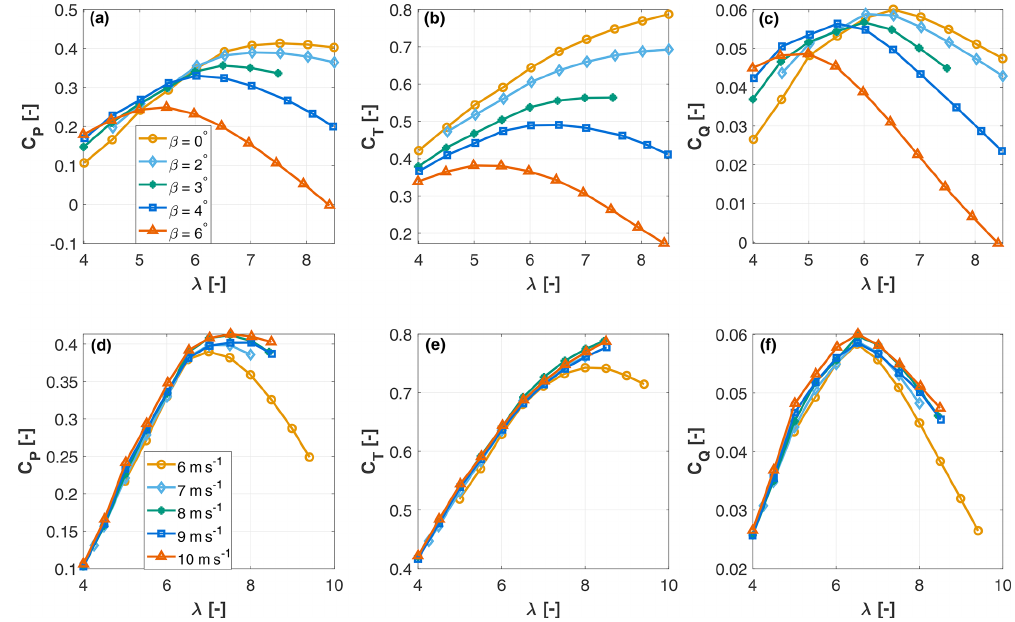
Figure 8. Power C P (a, d) , thrust C T (b, e) and torque C Q (c, f) coefficients as functions of TSR λ for different pitch angles β at 10ms − 1 (a– c) and for different wind speeds at the optimum pitch angle β = 0 ◦ (d–f) .